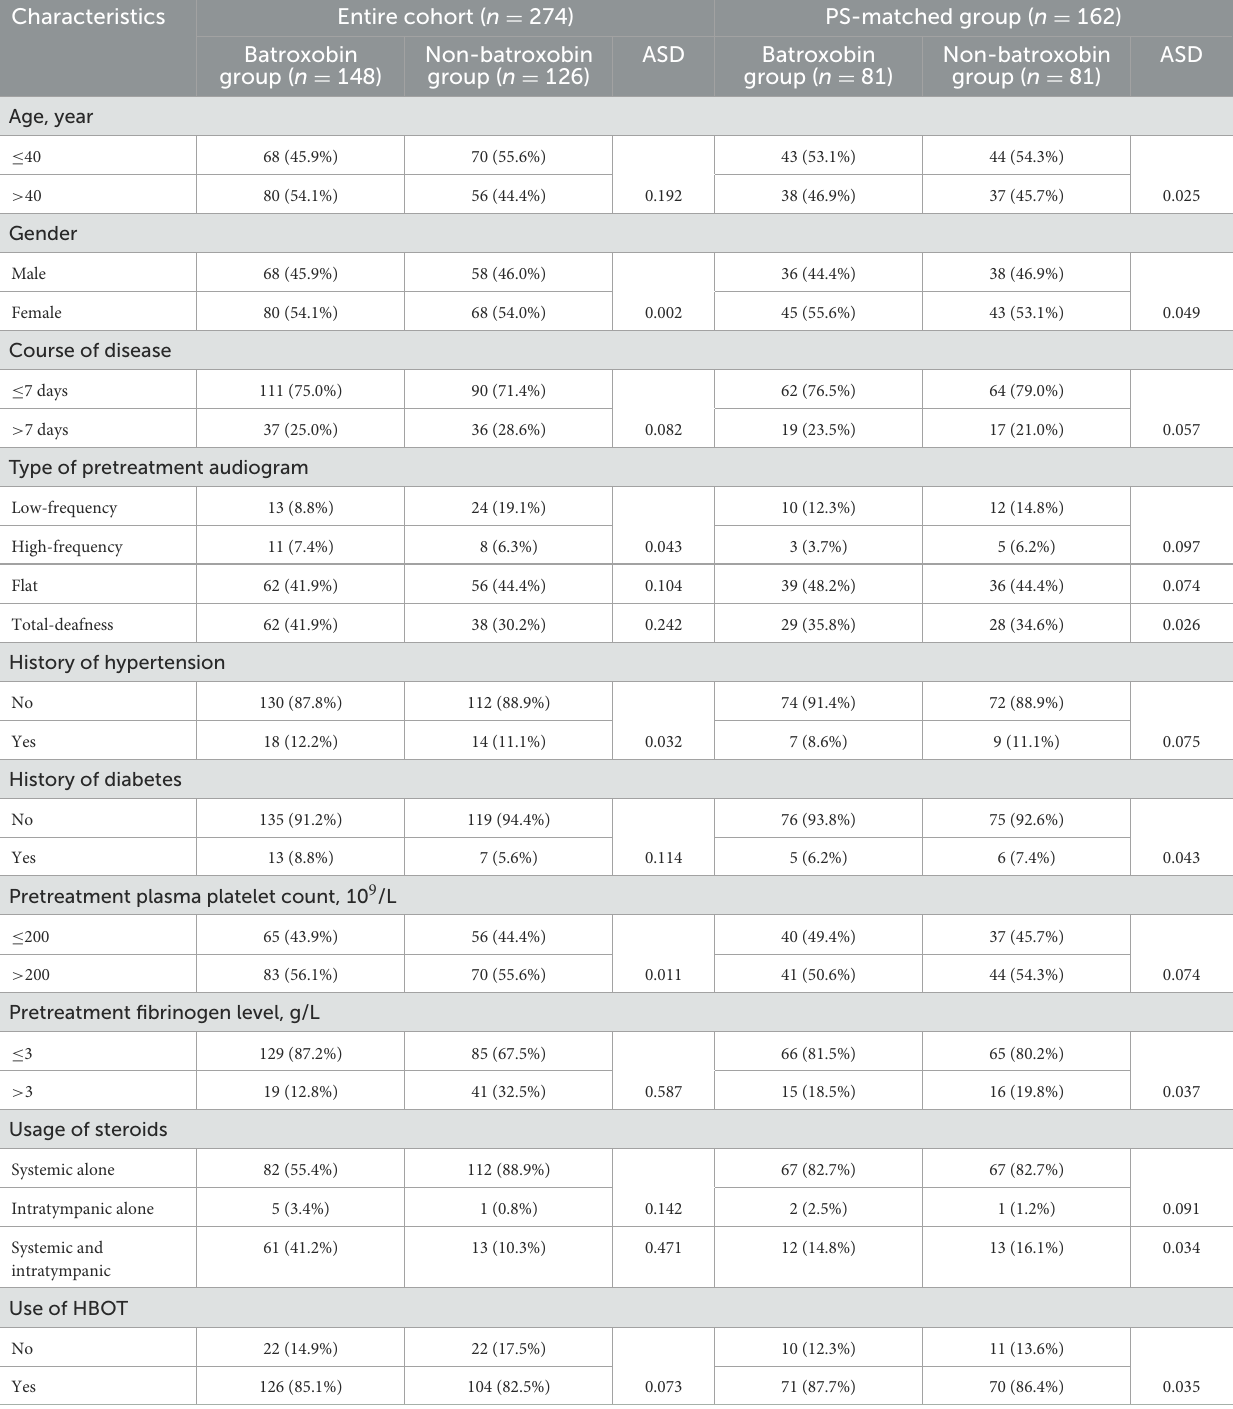
TABLE 1 Comparison of baseline characteristics between the batroxobin group and the non-batroxobin group in the entire cohort. Characteristics Entire cohort ( n = 274)